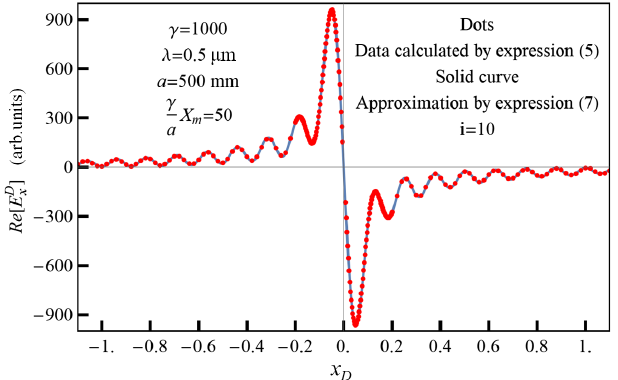
FIG. 6. Comparison of ℜ ½ E D x (cid:2) (points) according to Eq. (2) with the approximation Re ½ E D x (cid:2) (solid curve) given by Eq. (11) for a lens aperture of x m ¼ y m ¼ 50 .